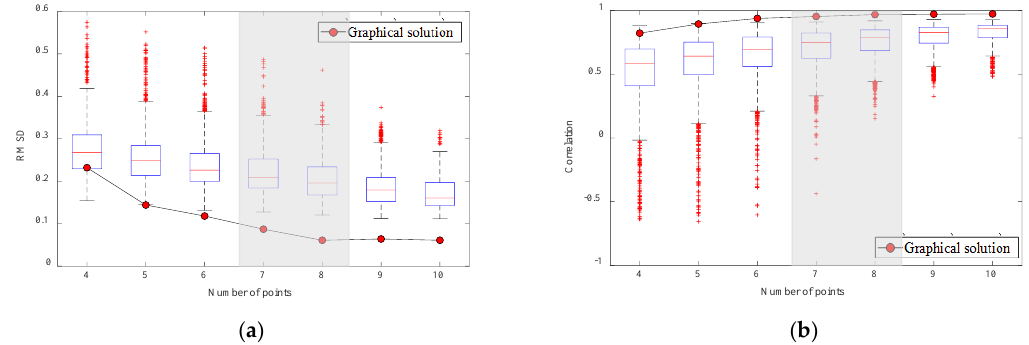
Figure 7. ( a ) Root mean square differences (RMSDs) and ( b ) correlation coefficient (CORs) of spatial distribution reconstructed by array of quantitative and graphical optimization.